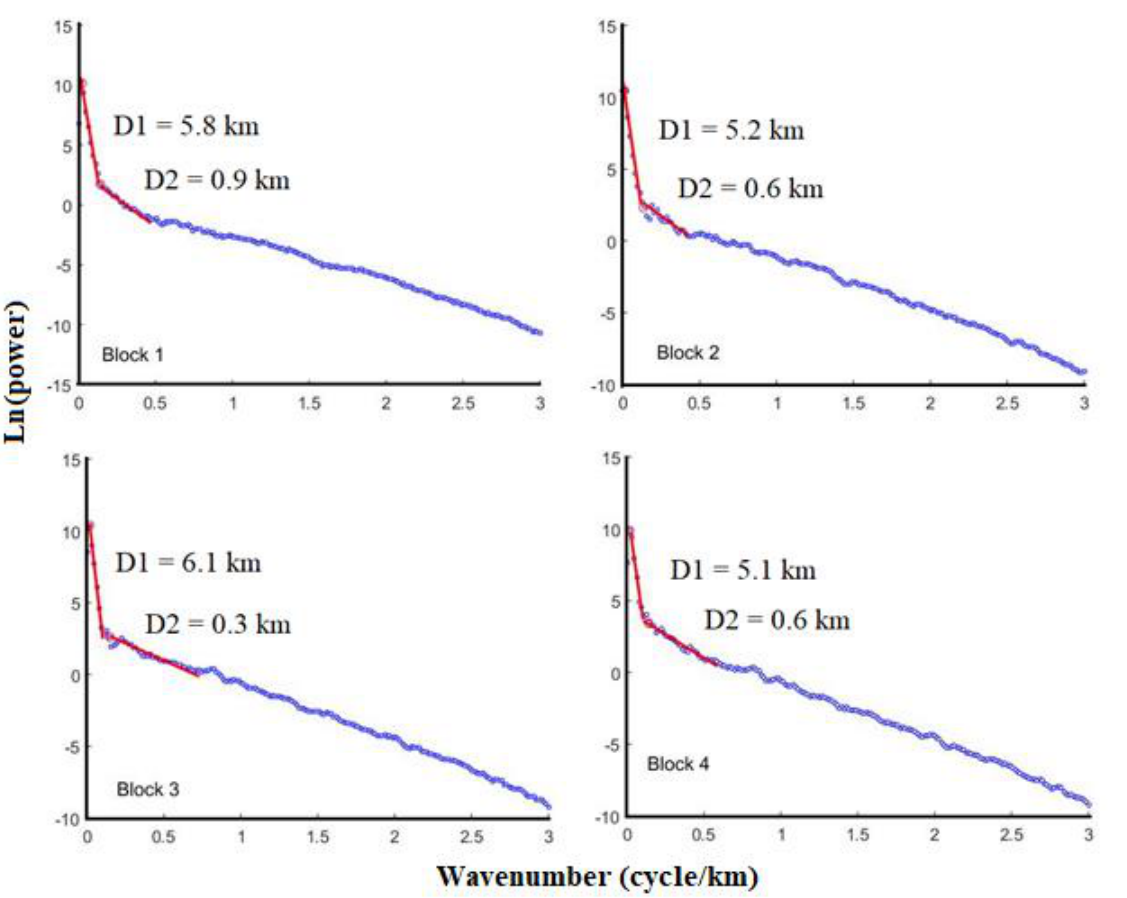
Figure 9. Plots for the power spectrum for blocks 1–4 (as displayed in Figure 5a). The depths to the deeper and shallower magnetic sources are represented by D1 and D2, respectively.